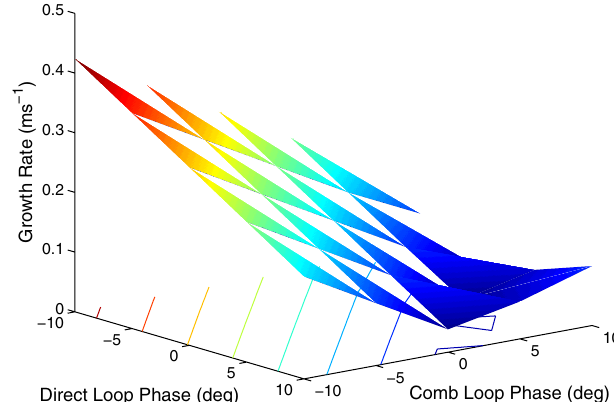
MODELING AND SIMULATION OF LONGITUDINAL . .